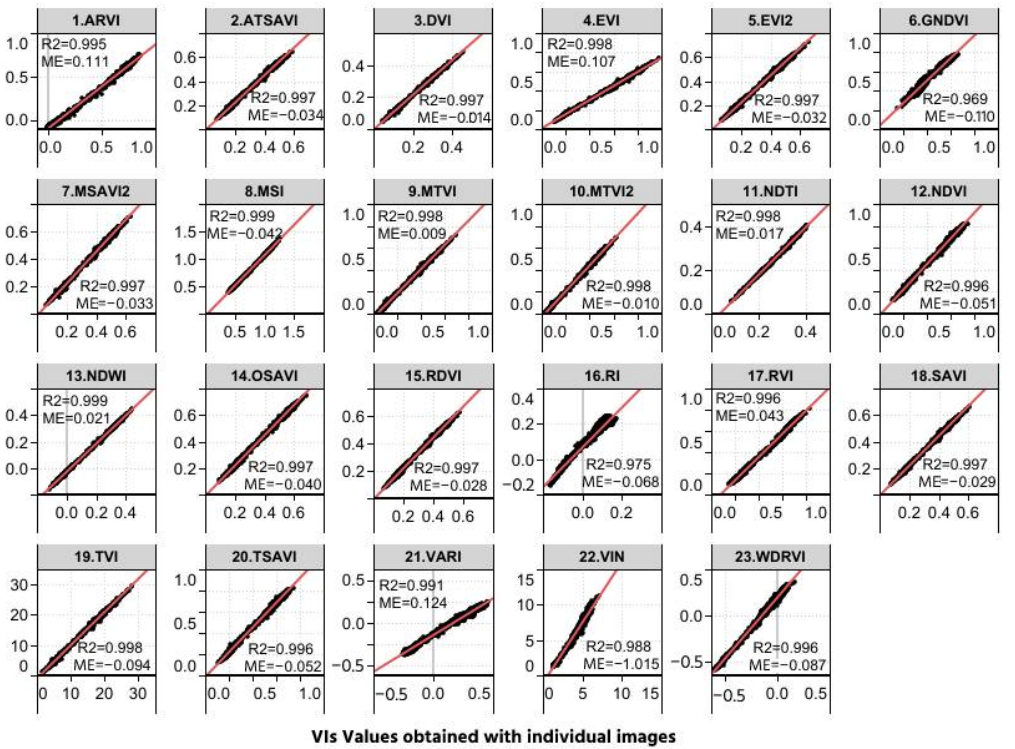
Figure 8. R 2 and ME values of the VIs obtained by VICAL and those obtained through the individual processing of Landsat-7 images.